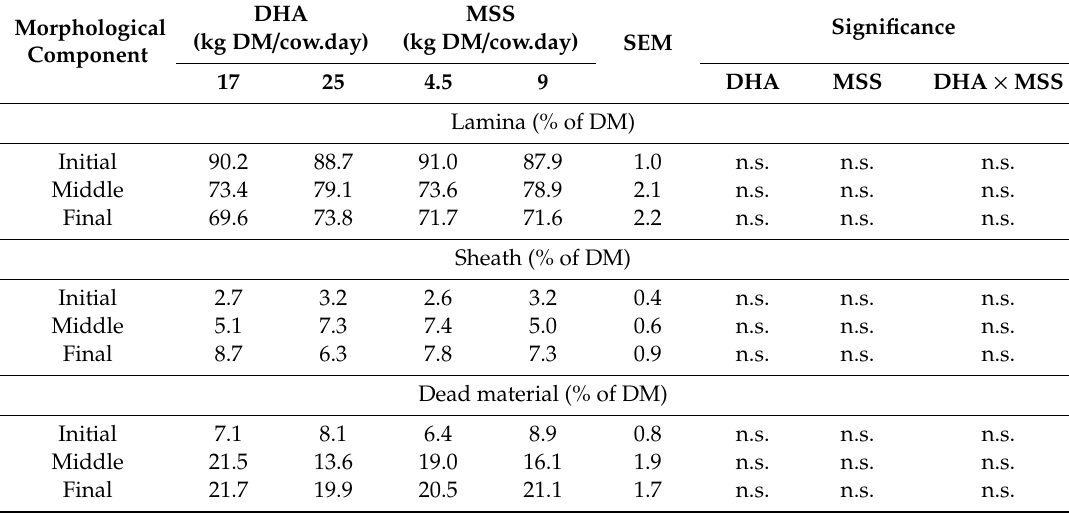
Table 4. Effects of daily herbage allowances (DHA) and maize silage supplementation (MSS) level on variations in the sward morphological components above 4 cm during grazing. Morphological